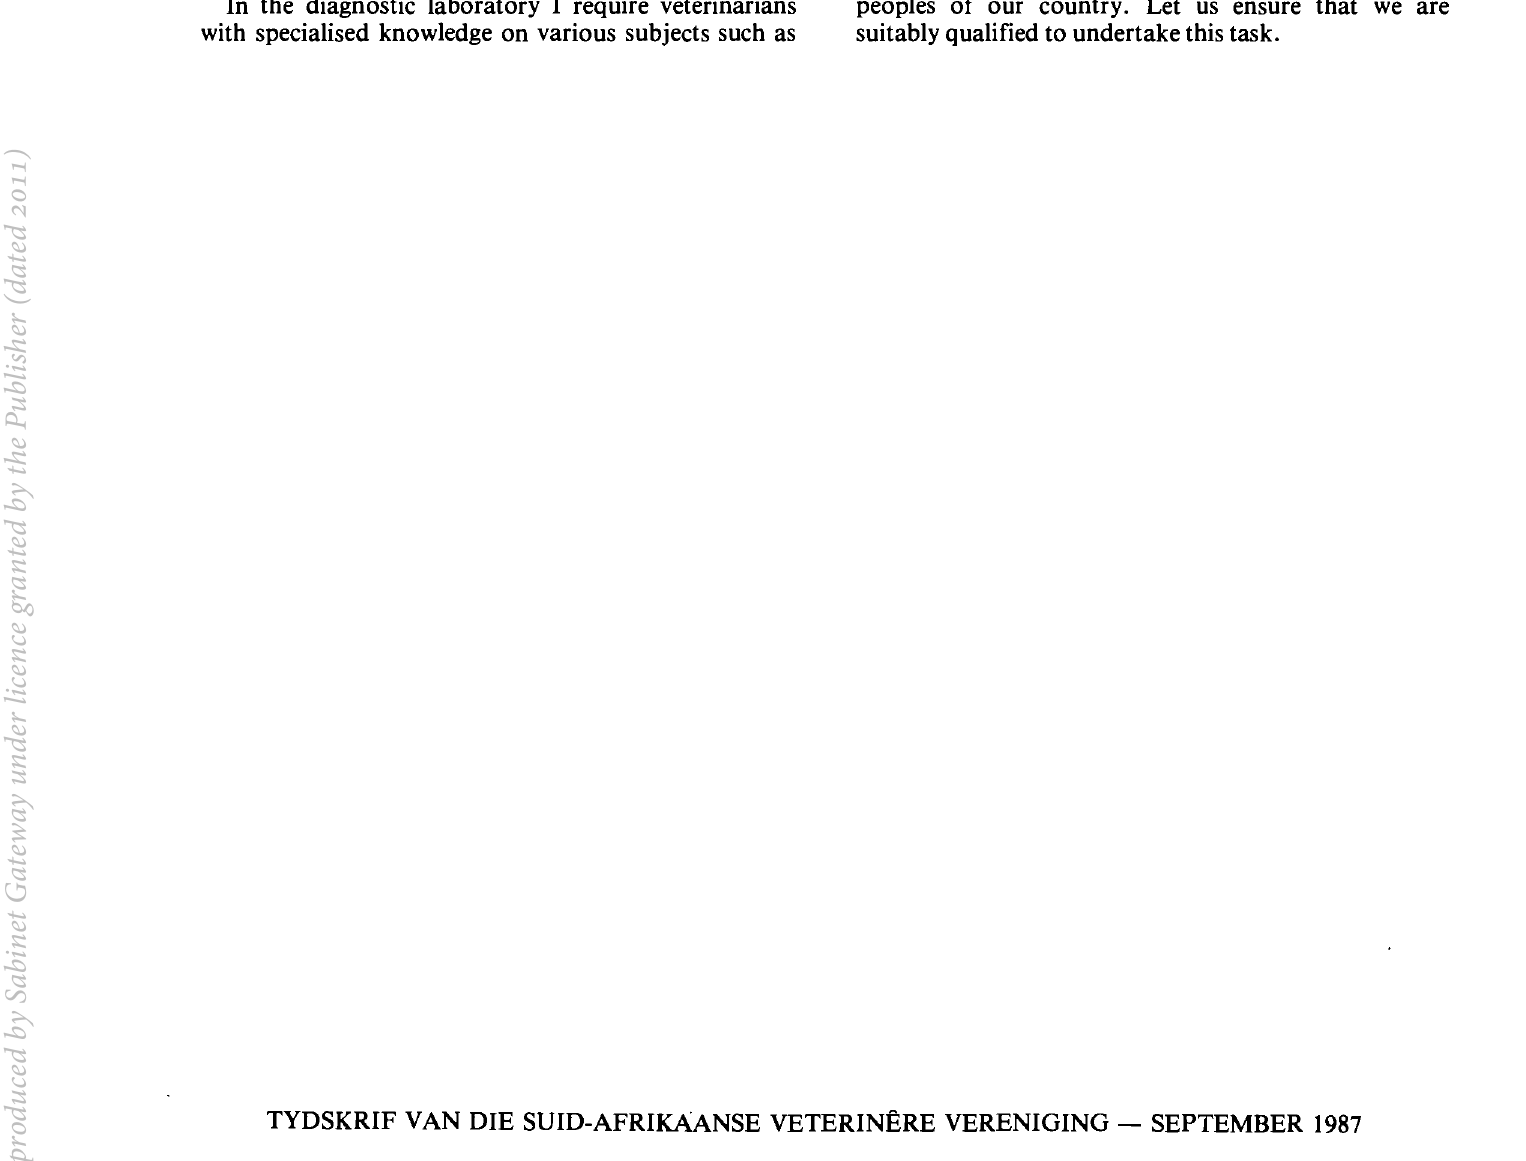
TYDSKRIF VAN DIE SUID-AFRlKAANSE VETERINERE VERENIGING - SEPTEMBER